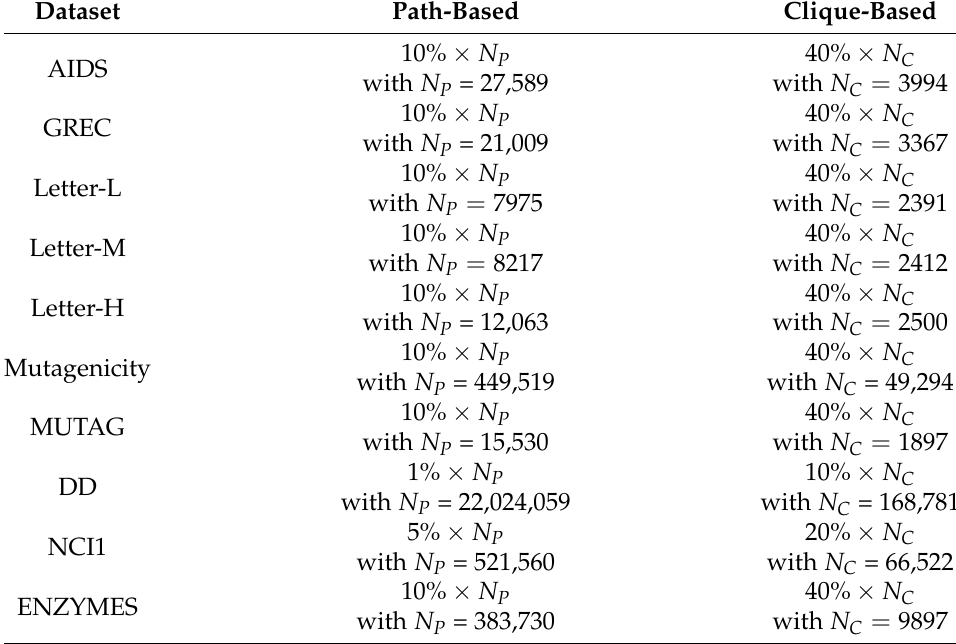
Table 2. Size of W for path-based and clique-based Granulators. Here, N P and N C refer to the number of paths of maximum order o = 5 and the total number of maximal cliques that can be drawn from the training set,